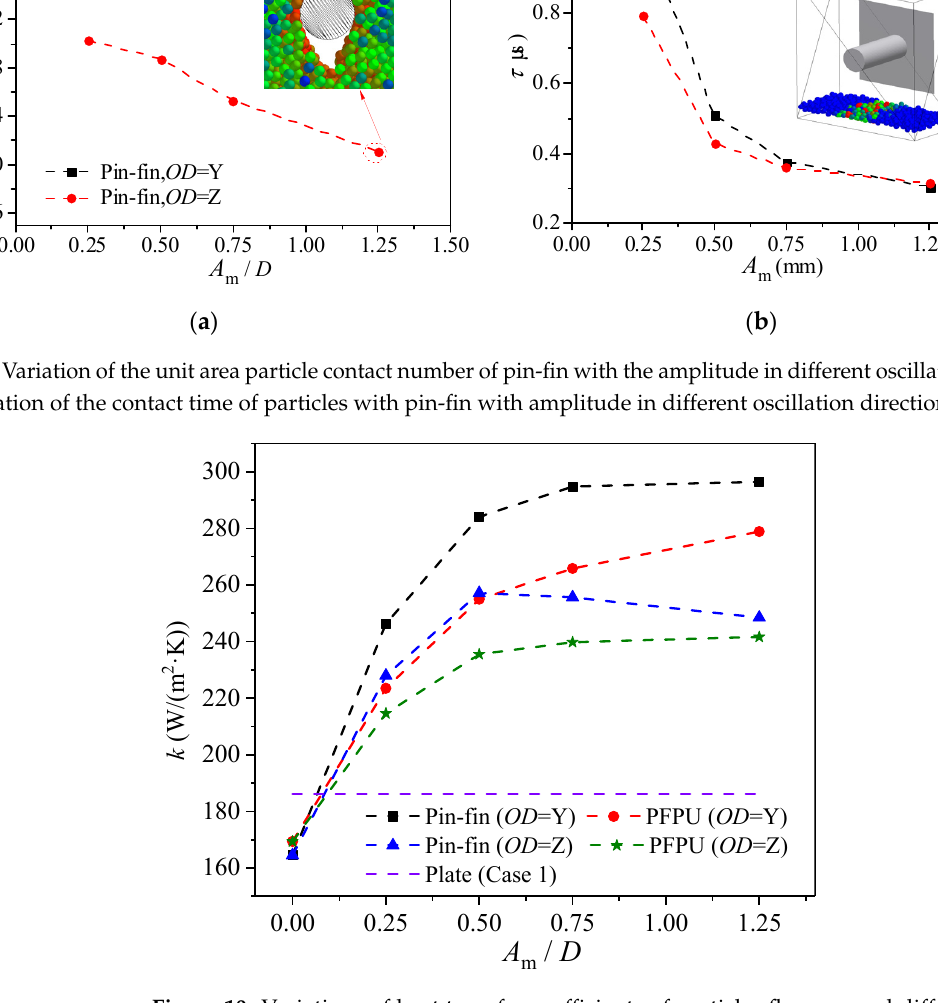
Figure 9. ( a ) Variation of the unit area particle contact number of pin-fin with the amplitude in different oscillating directions; and ( b ) variation of the contact time of particles with pin-fin with amplitude in different oscillation directions.